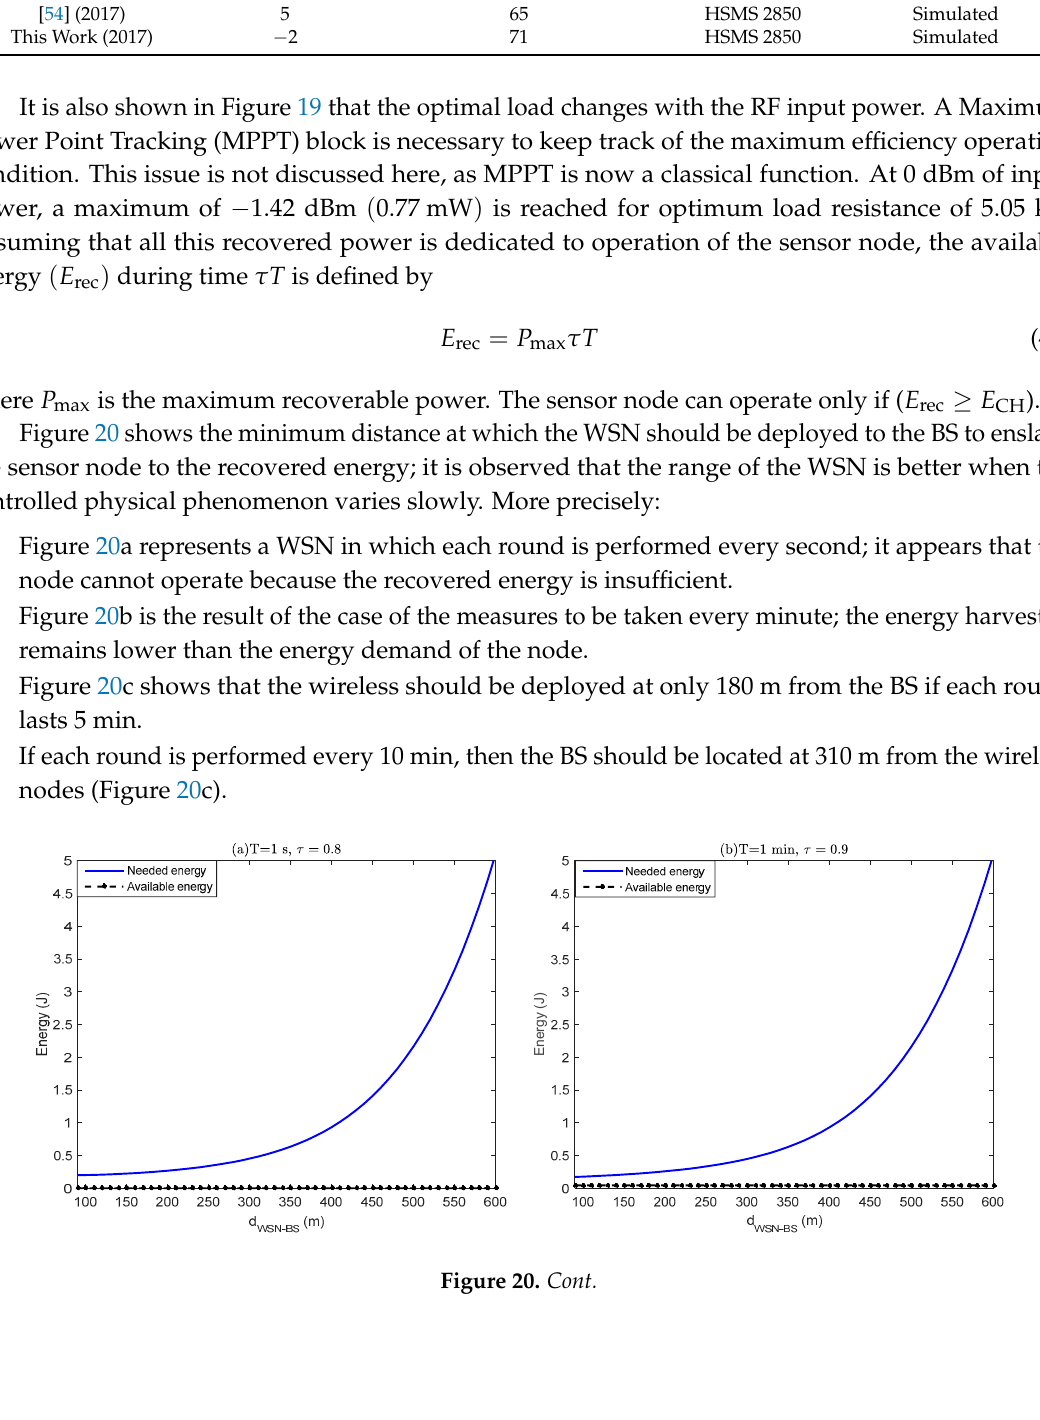
Table 6. Comparison of the proposed rectenna and related designs.